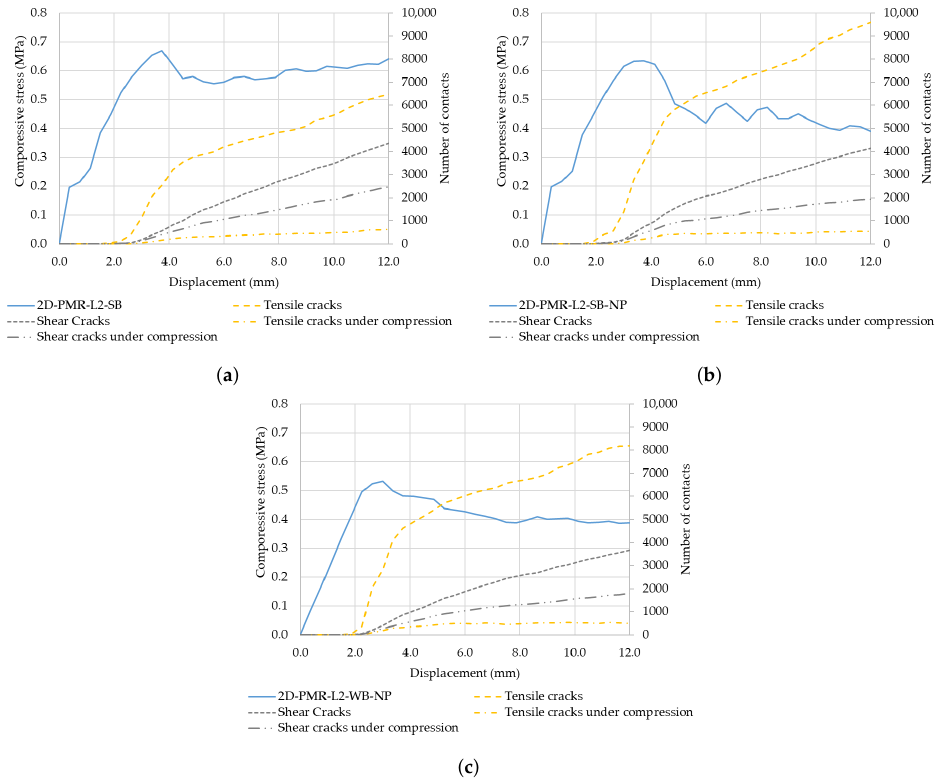
Figure 20. Stress–displacement diagram and crack evolution for the 2D-PMR models with and without plates for strong and weak bond approaches. ( a ) 2D-PM-L2-SB; ( b ) 2D-PM-L2-SB-NP; ( c )